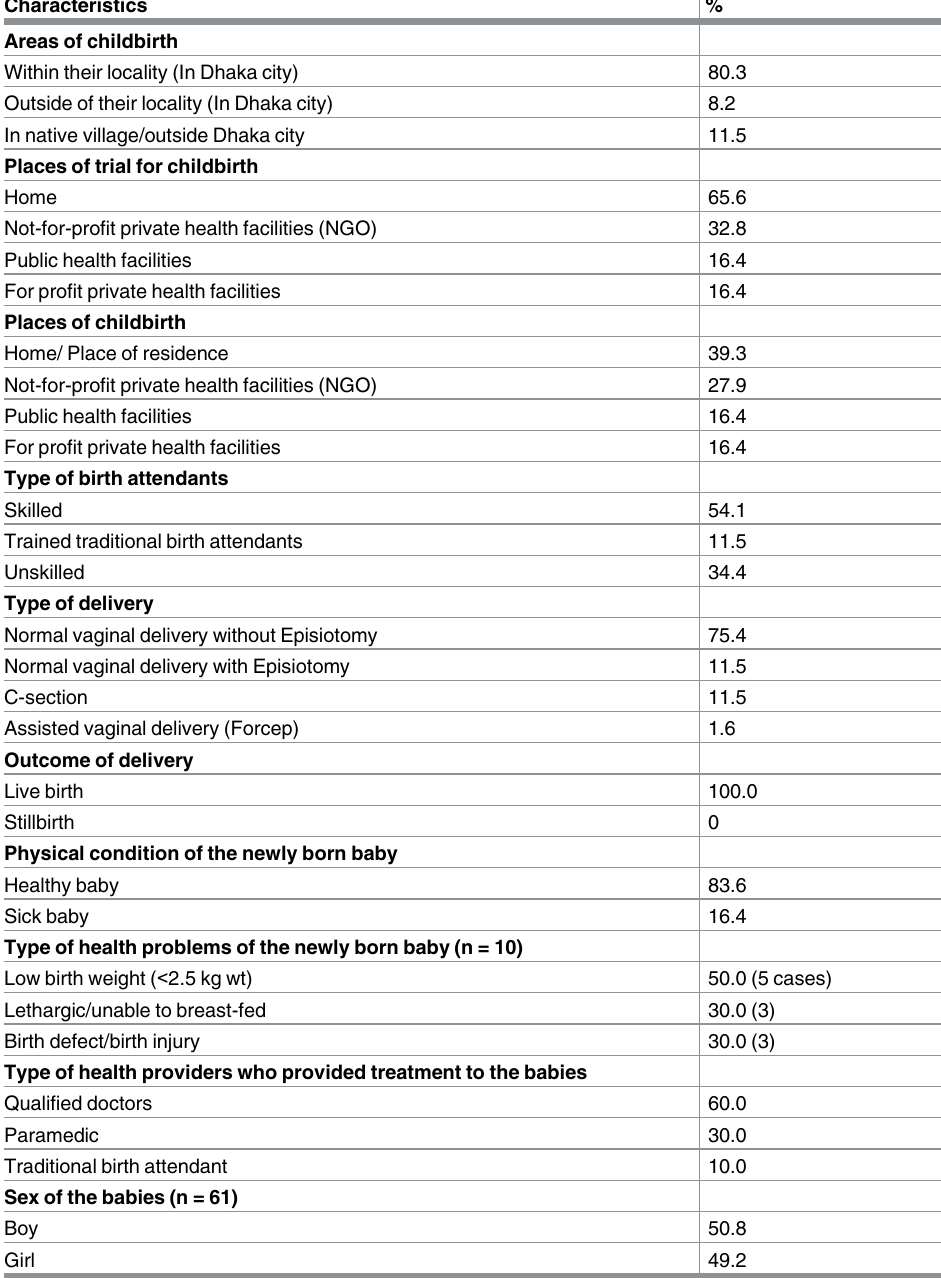
Table 5. Deliverycare of FSWs who had a childbirth in last one year (n = 61).